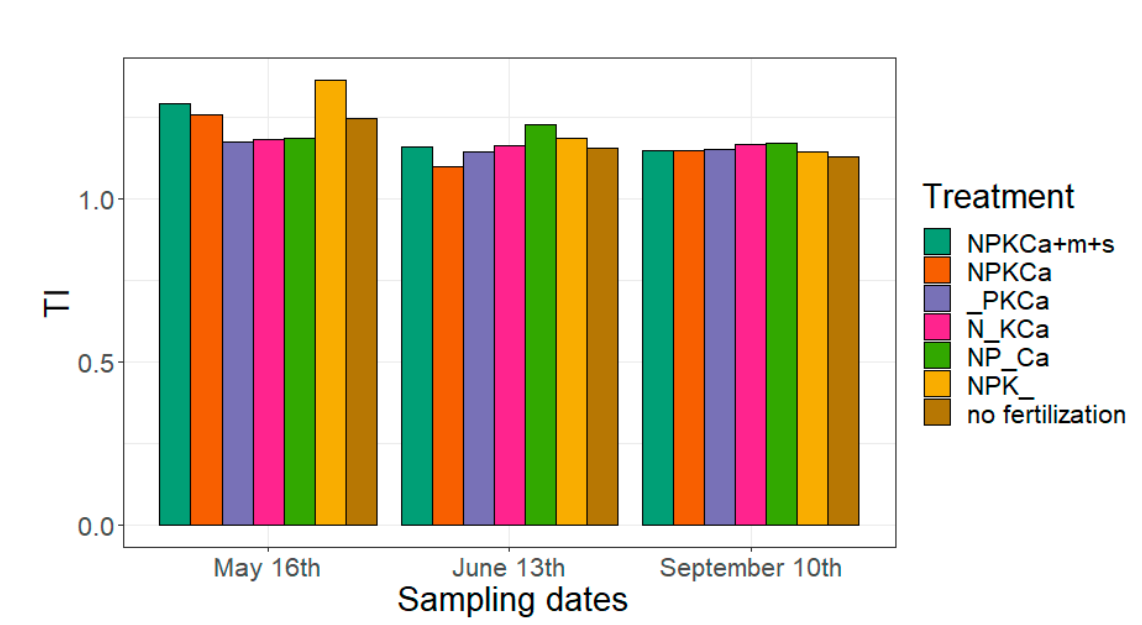
Figure 6. Topological index (TI) of sugar beet topsoil root system for all considered treatments at three sampling dates in 2019 at the long term fertilizer experiment Dikopshof, Germany.